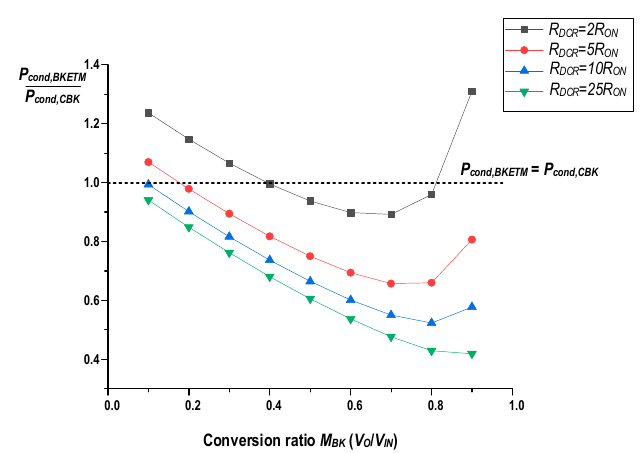
Figure 7. Conduction loss comparison for the buck converter with energy transfer media (BKETM) and conventional buck converter (CBK) with different R DCR values.